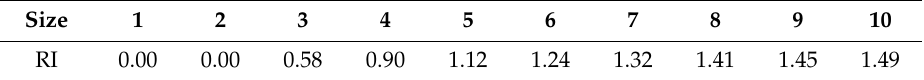
Table 8. Consistency index for randomly generated matrices